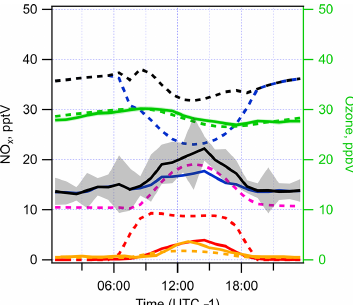
Figure 6. Left is the total production and loss analysis for NO x of the combined model of particulate nitrate photolysis and PAN decomposition over 24h. Right is the same analysis discarding the major balanced sinks of fast cycling short-lived